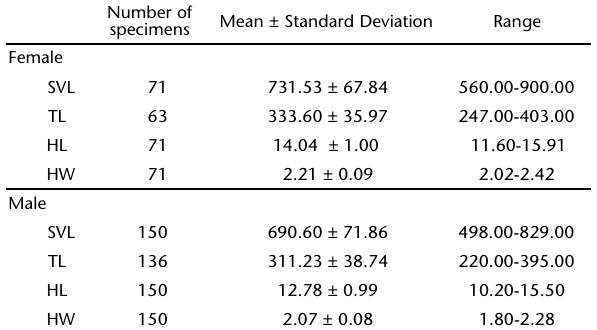
Table I. Morphometry of sexually mature females and males of Imantodes cenchoa from the Brazilian Amazon, showing the number of specimens examined (N), mean, standard deviation and range. (SVL) Snout-vent length (mm), (TL) tail length (mm), (HL) head length (mm), (HW) head width